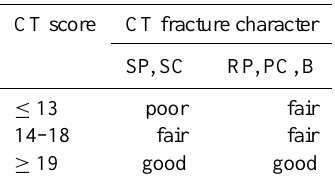
Table 1. Point stability classification based on CT score and CT fracture type.